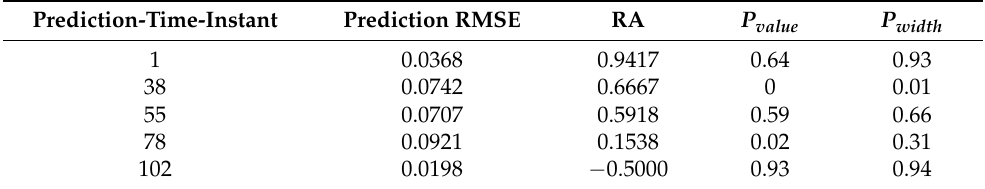
Table 13. The RMSE, RA, P value and P width of 5 time-instant of interest on tests 2 (B0018 and linear).